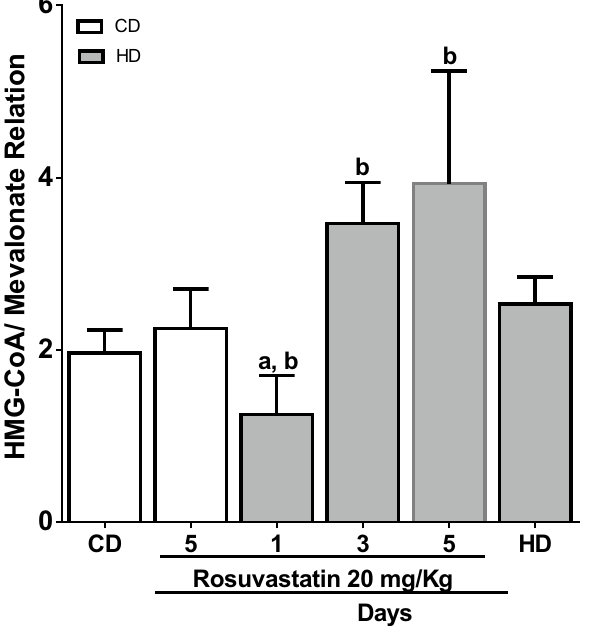
Figure 1. Absorbance of 3-hydroxymethylglutaryl-CoA/mevalonate ratio in the liver homogenate. CD control diet, HD hypercholesterolemic diet. Key of significance: a compared with CD and b with HD ( p < 0.05).